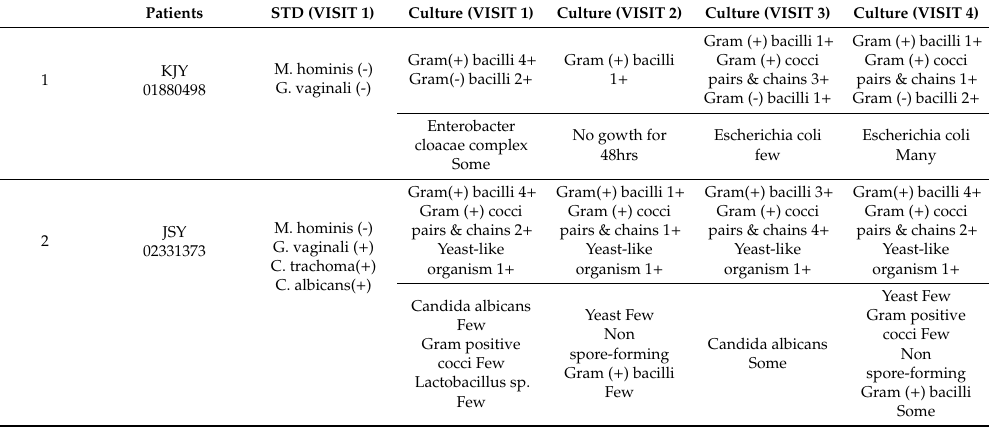
Table 1. Information and test results of control